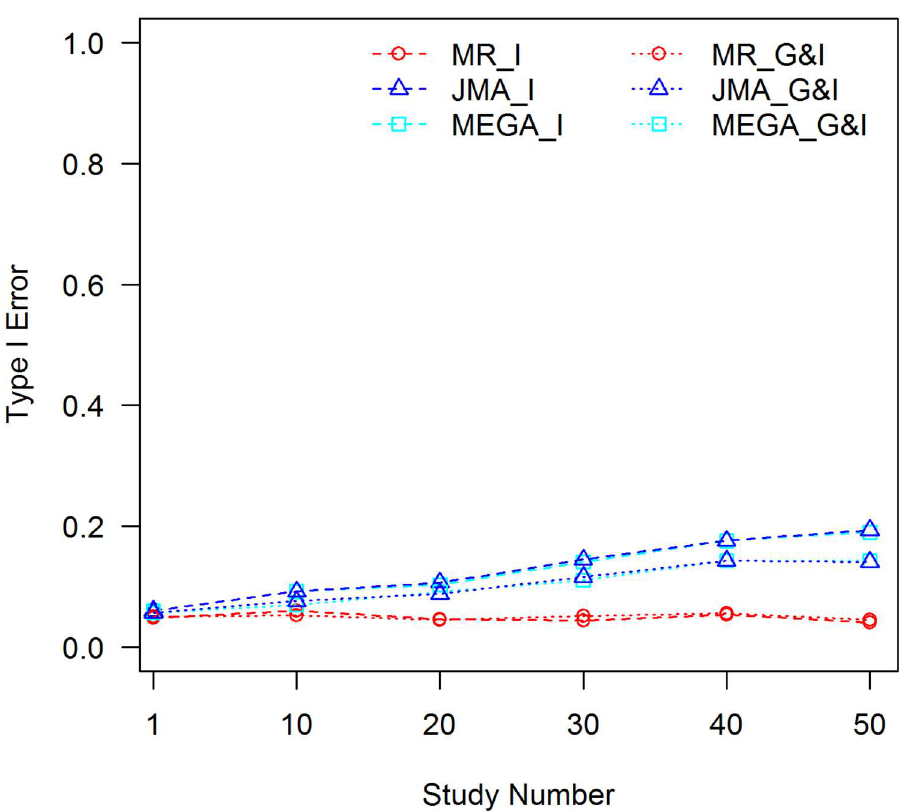
Fig 3. Tests of interaction without controlling for the C × E confounder, f 1 = 0.3, f 2 = 0.1; confounder is present in half of the studies. MR_I: MR test of interaction; MR_G&I: MR joint test of the genetic main effect and interaction; JMA_I: JMA test of interaction; JMA_G&I: JMA joint test of the geneticmain effect and interaction; MEGA_I: mega-analysis test of interaction; and MEGA_G&I: mega-analysis joint test of the geneticmain effect and